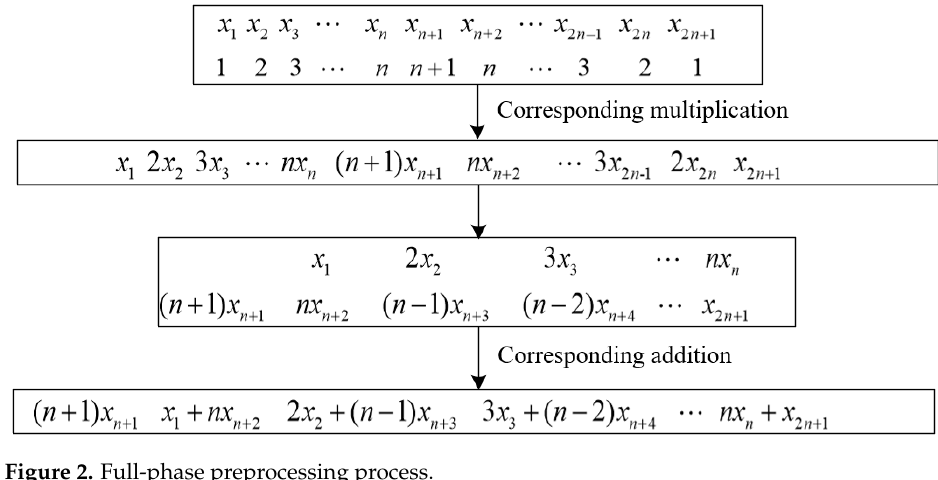
Figure 2. Full-phase preprocessing process.